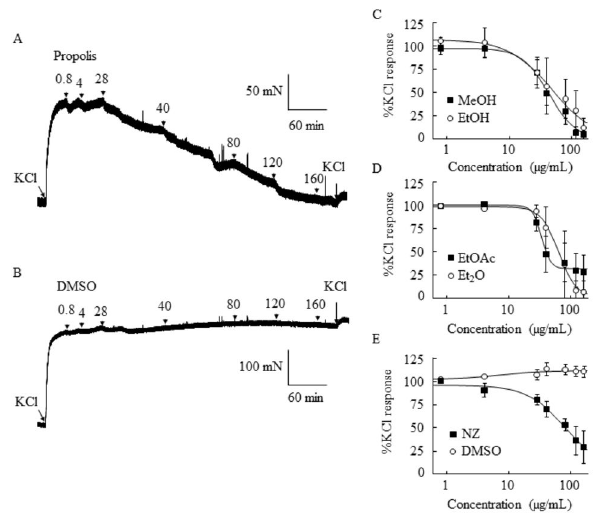
Figure 2. Effect of Australian stingless bee T. carbonaria propolis and New Zealand honeybee propolis (NZ) on vascular tone in isolated blood vessel preparations. A methanolic extract of propolis (0.8-160 µg/ml) produced a dose-dependent relaxant response in porcine coronary artery rings (A), while solvent (dimethyl sulfoxide, DMSO) was without effect (B). Concentration effect curves for methanolic (MeOH) and ethanolic (EtOH) extracts of stingless bee propolis (C). Concentration effect curves for ethyl acetate (EtOAc) and diethyl ether (Et O) sub-fractions of the methanolic extract of stingless bee T. carbonaria 2 propolis (D). Concentration effect curves for an ethanolic extract of New Zealand honeybee propolis, and DMSO (E). doi: